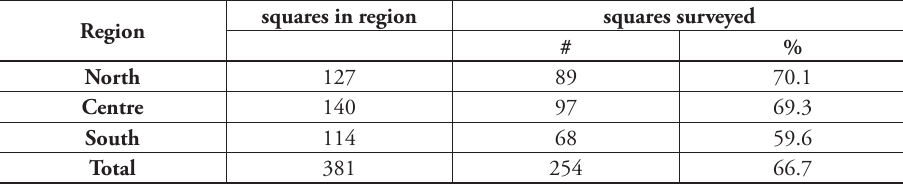
Table 1. Number of squares of the UTM 10×10 km grid per region and number and percentage of squares surveyed between March 2014 and December 2017.